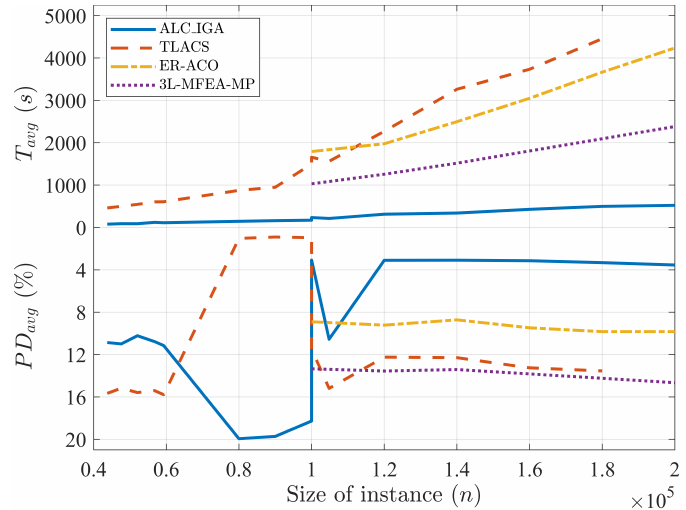
Figure 9. The computation time of the compared algorithms with parallelization on large-scale TSPs.